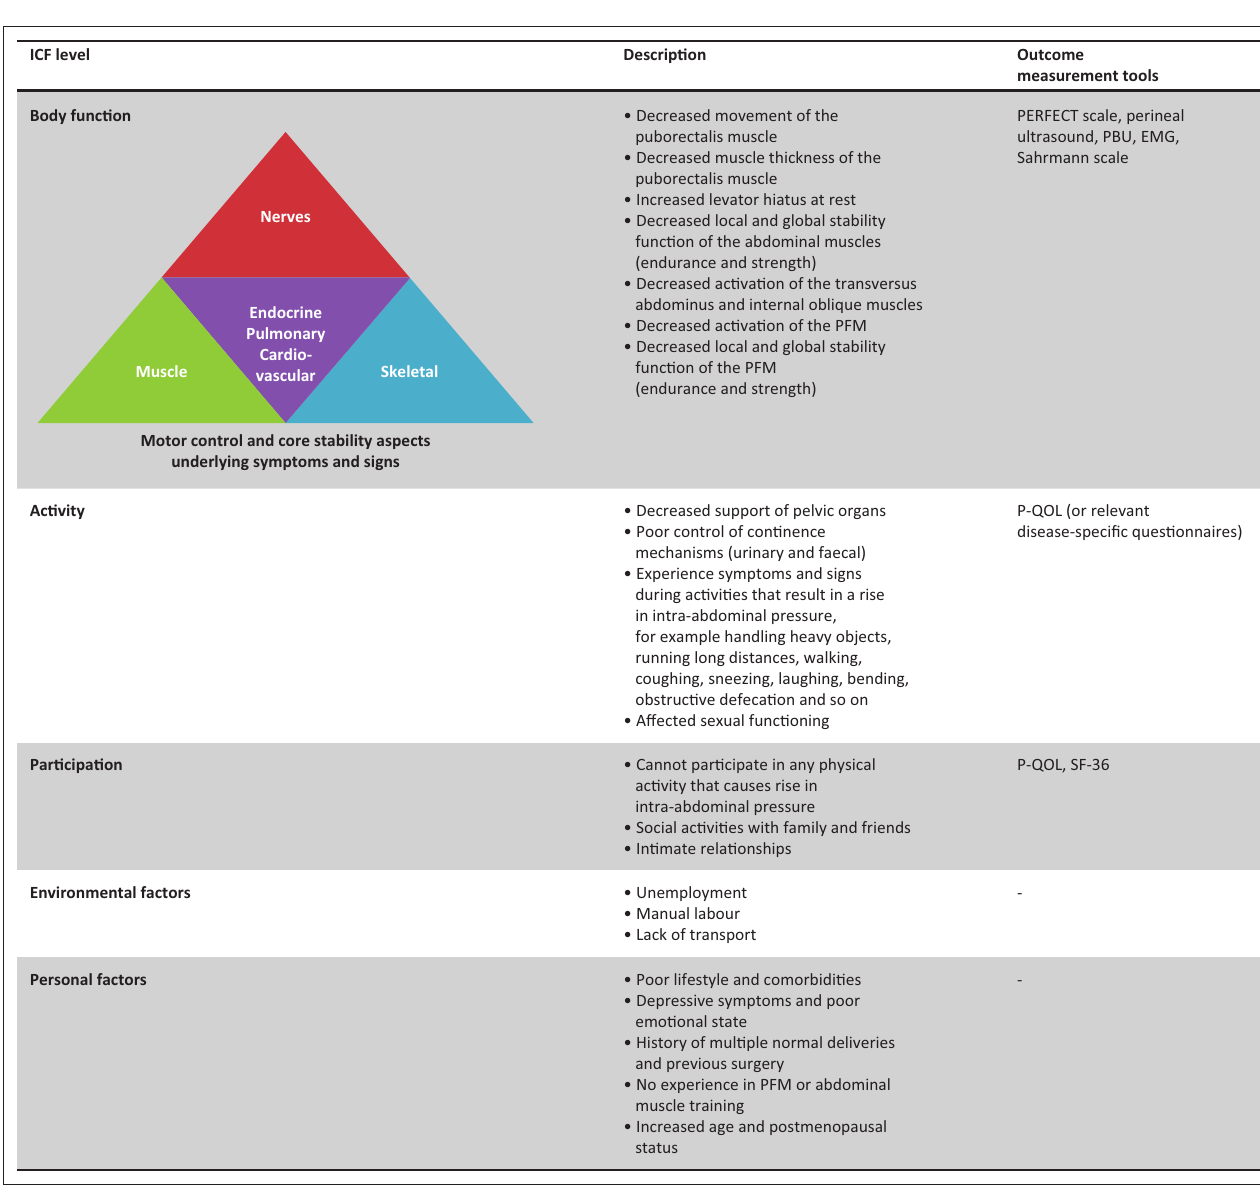
FIGURE 2: Proposed summary of the findings regarding movement impairment of the abdominal and pelvic floor muscles in women with pelvic organ prolapse within an ICF and motor control